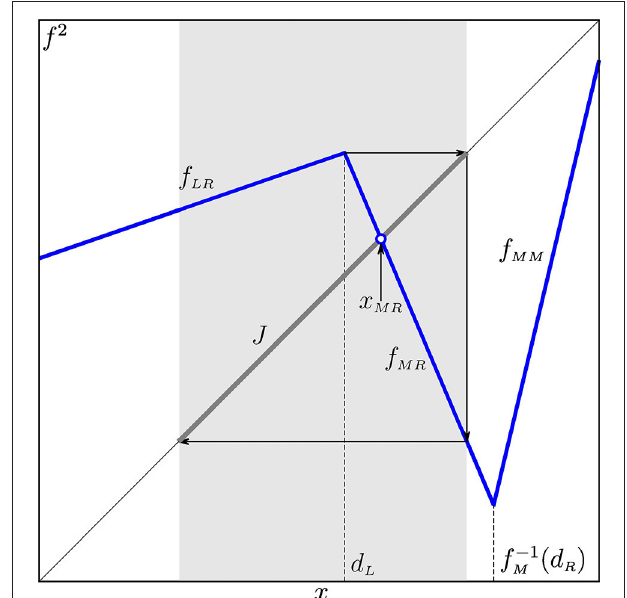
FIGURE 11 | The local absorbing interval J of f 2 including d L for p ∈ D L , LR st